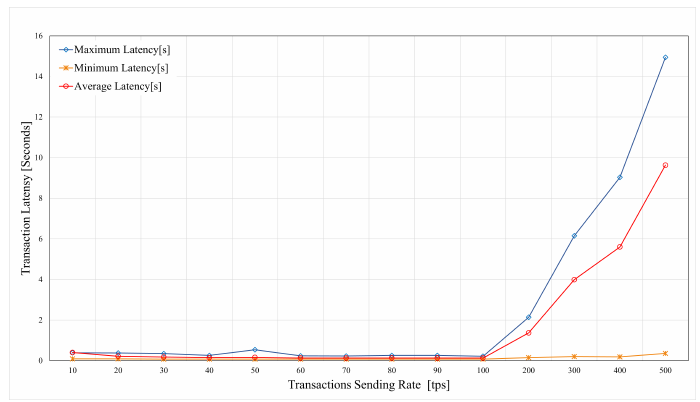
Figure 11. Latency vs. transaction sending rate.